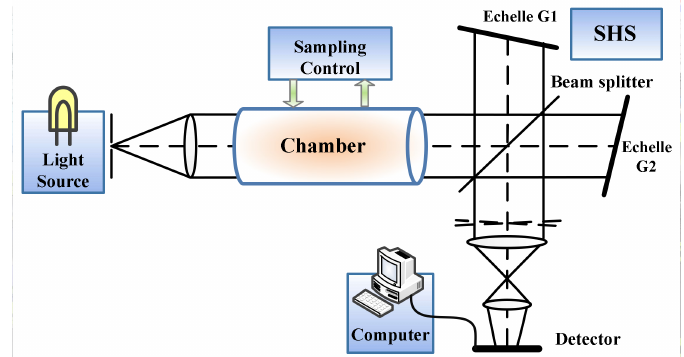
Figure 2. Structure of the visual e-nose